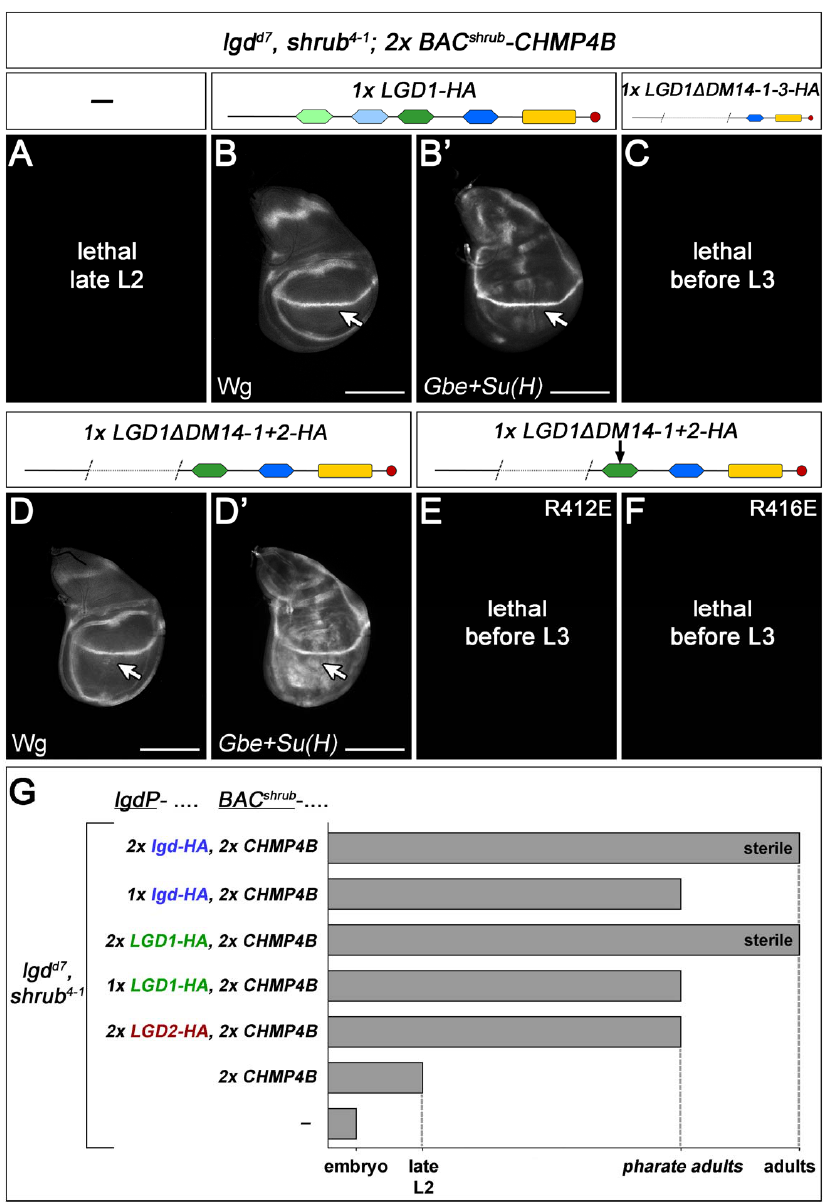
Figure 5. Analysis of the LGD–CHMP4B interaction. ( A – F ) The lgdP -LGD1 variants were introduced into lgd shrub double mutants ( lgd d7 ; shrub 4 − 1 ) together with two copies of BAC shrub -CHMP4B . ( A ) In the presence of two copies of BAC shrub -CHMP4B , lgd shrub double mutants die at the late second instar larval stage. ( B , G ) The additional presence of one copy of lgdP -LGD1-HA results in a strongly improved rescue to the pharate adult stage. In the corresponding wings discs, the expression of Wg and Gbe+Su(H) is normalised (arrow, compare with Figure 3A). ( D , D’ ) The presence of LGD1 ∆ DM14-1+2 results in a weaker rescue than the full-length LGD1, indicated by the slight ectopic activation of the Notch pathway (arrow). ( C ) This rescue ability is abolished if the third DM14 is removed (LGD1 ∆ DM14-1-3), or if one of the two positively charged AAs within DM14-3 is exchanged (R412 or R416) (compare ( D , D’ ) with ( E , F )). ( G ) Summary of the rescue of lgd shrub double mutants with combinations of CHMP4B and the LGDs. CHMP4B in combination with two copies of LGD1 resulted in a full rescue of the shrub lgd double mutant flies, with the exception of the sterility. The combination of two copies of LGD2 and CHMP4B led to an incomplete rescue of shrub lgd double mutant flies to the pharate adult stage. As a control CHMP4B was also expressed with two copies of lgdP-lgd-HA . Scale bars 200 µ m. At least ten wing imaginal discs were analysed for each